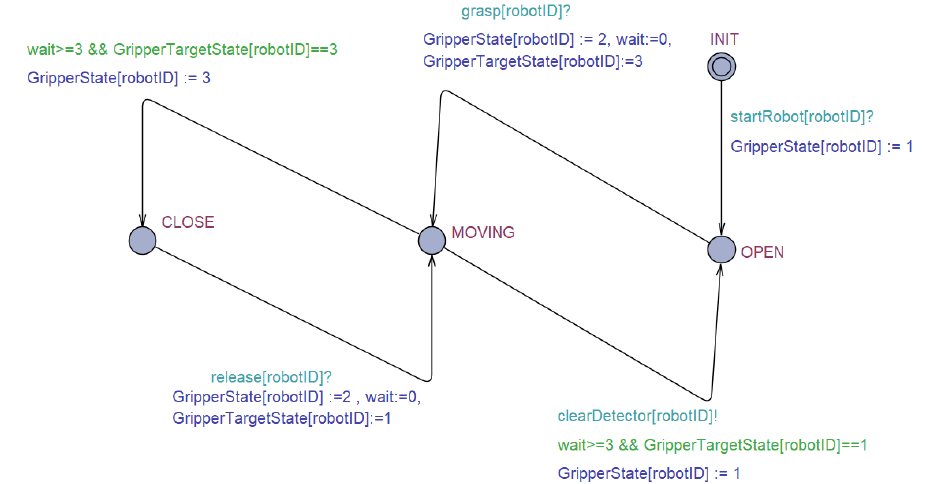
Figure 9. Block diagram of the gripper module. Figure 8. UPPAAL Timed automata model of gripper. Figure 8. UPPAAL Timed automata model of gripper.